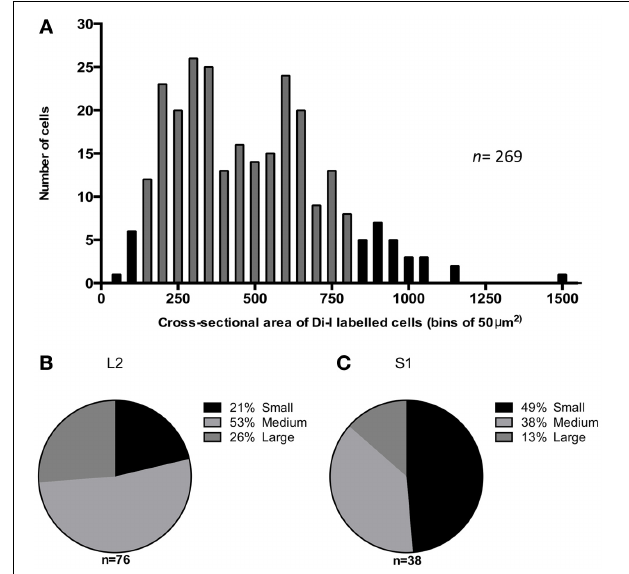
FIGURE 3 | Cross sectional area of DiI labeled cells in mouse dorsal root ganglia. (A) Distribution of 269 labeled neurons, selected from DRGs at all spinal levels in four mice plotted as number of cells observed in each 50 μ m 2 bins of cross-sectional area. The gray bars indicate 87% of the population are between 100–800 μ m 2 (B,C) Proportion of DiI labeled cells that are small ( < 300 μ m 2 ), medium (300–600 μ m 2 ) or large ( > 600 μ m 2 ) at L2 and S1